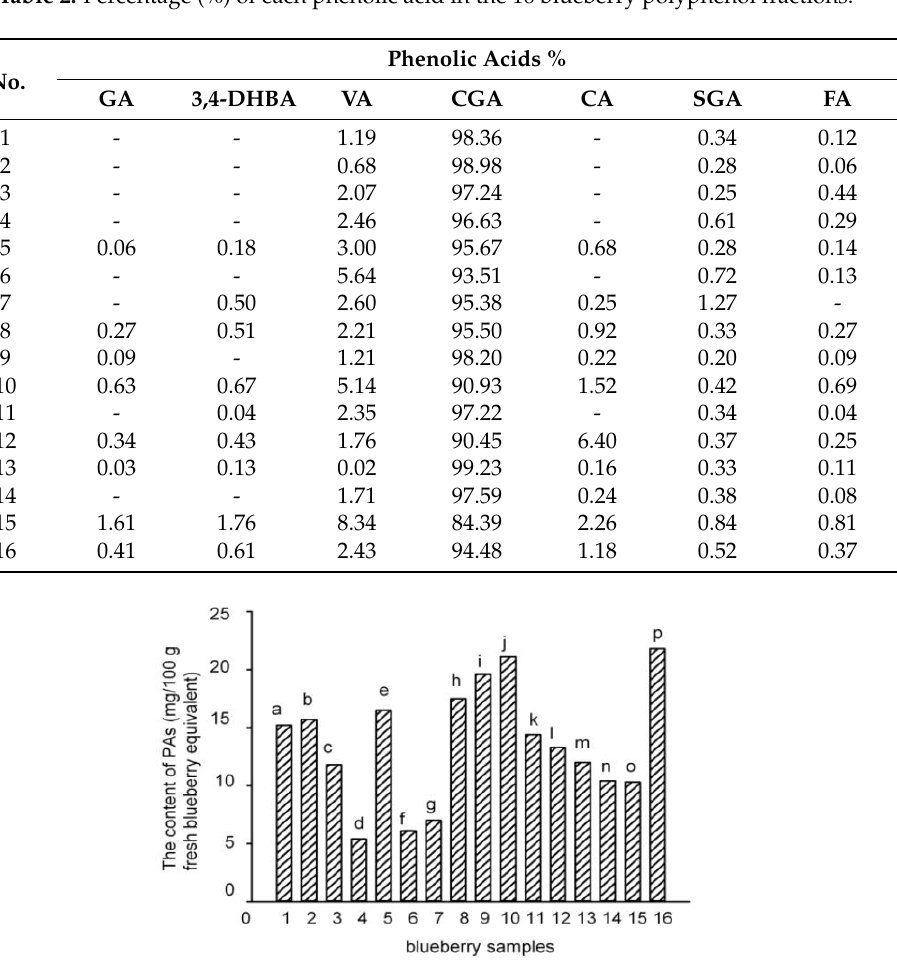
Table 2. Percentage (%) of each phenolic acid in the 16 blueberry polyphenol fractions.